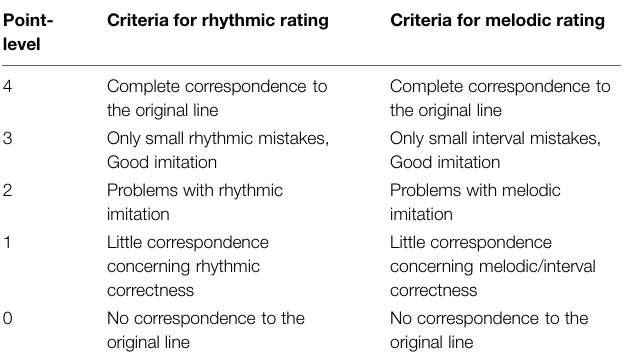
TABLE 2 | Rating scale for imitated rhythmic and melodic sequences. TABLE 3 | Mean values (%) of correct answers for receptive tests ( ± one standard